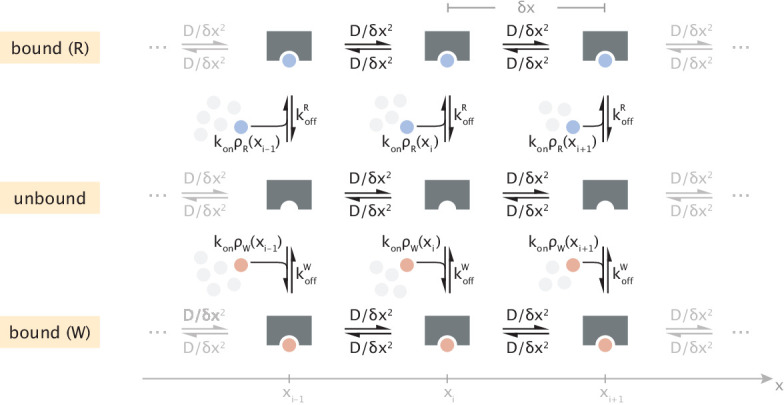
Discrete-state representation of diffusive transport and substrate binding/unbinding events.Transparent clusters of different numbers of substrates illustrate the spatial variation of substrate concentration.